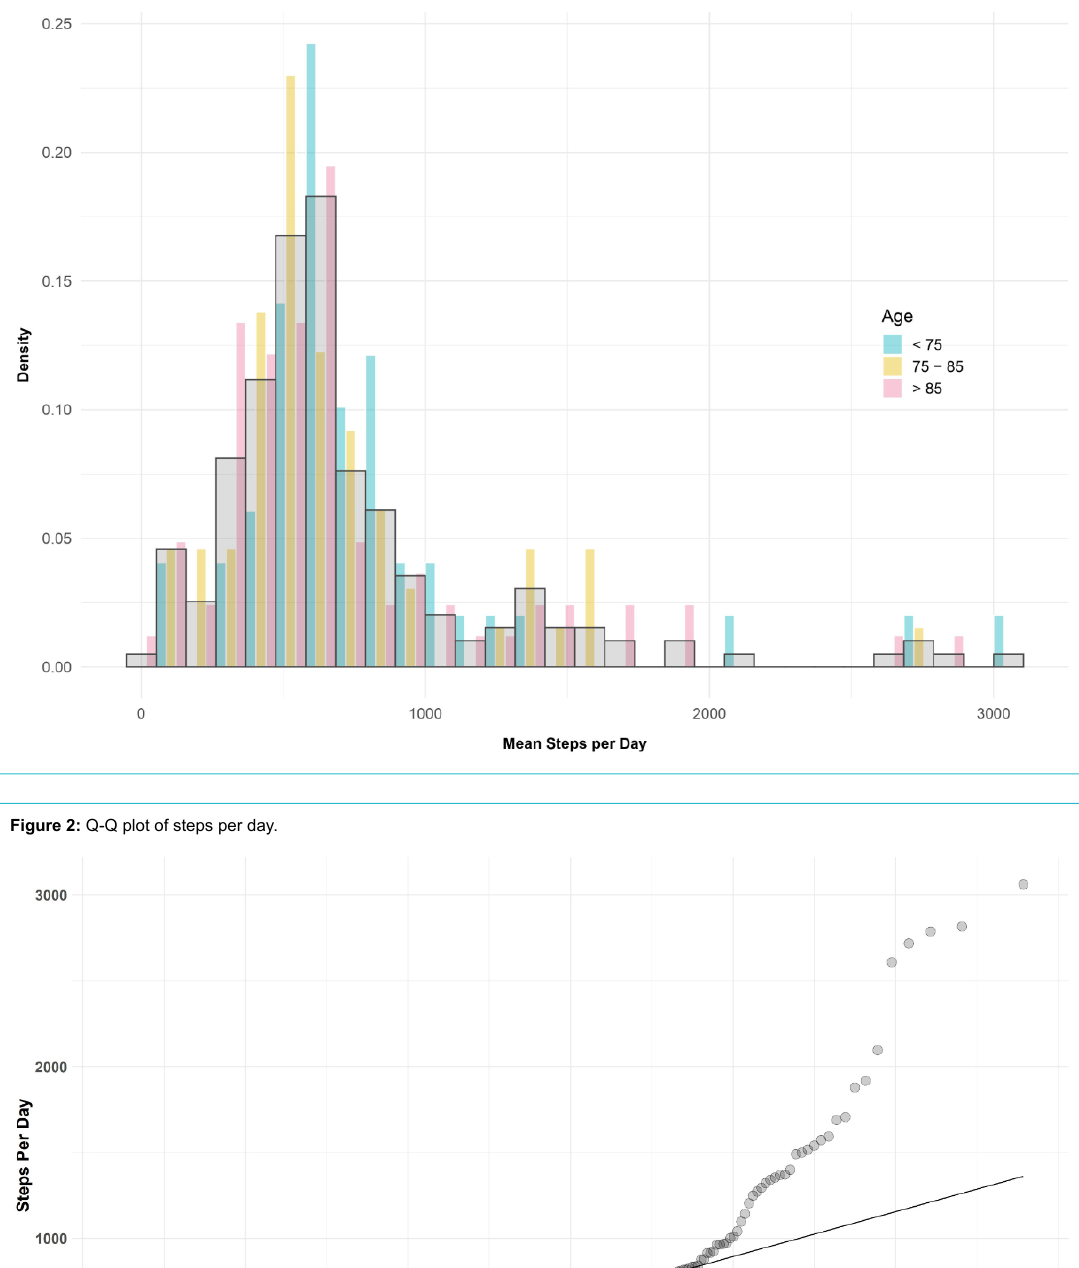
Figure 1: Frequency of mean step per day, stratified by age group.